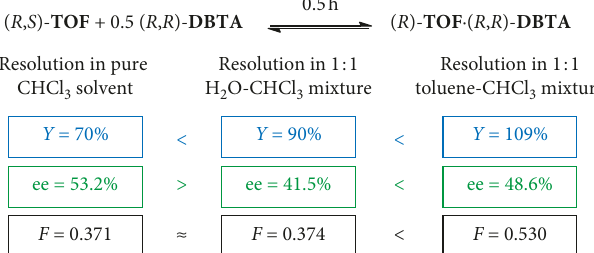
Scheme 7: Effect of water-toluene substitution on resolution efficiency.